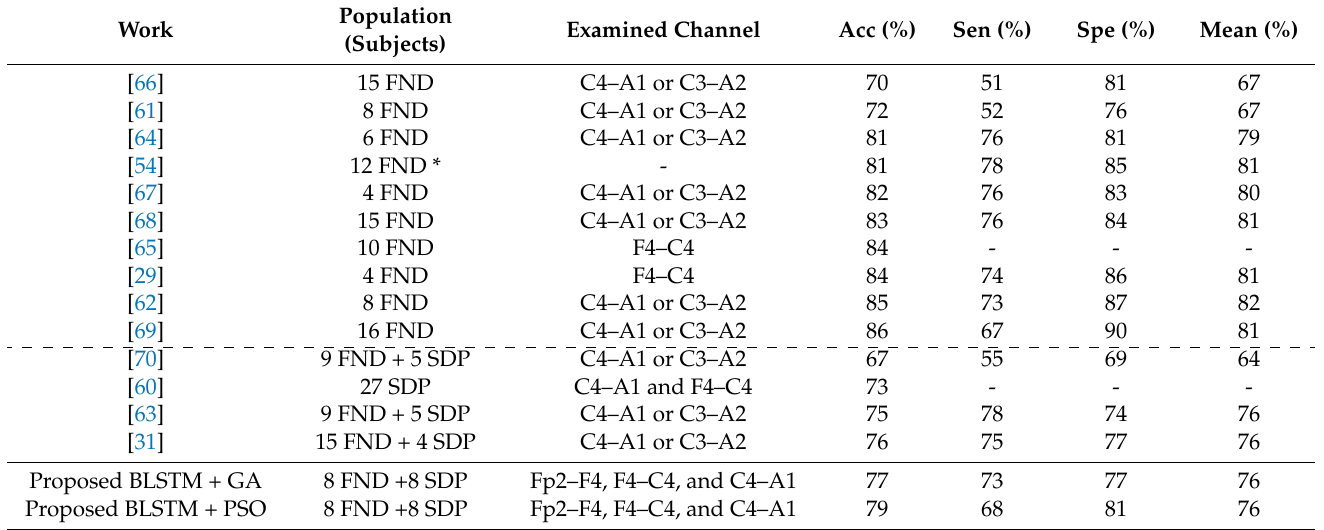
Table 4. Comparative analysis between results reported by the state-of-the-art works and the results attained in this work with subjects FND and